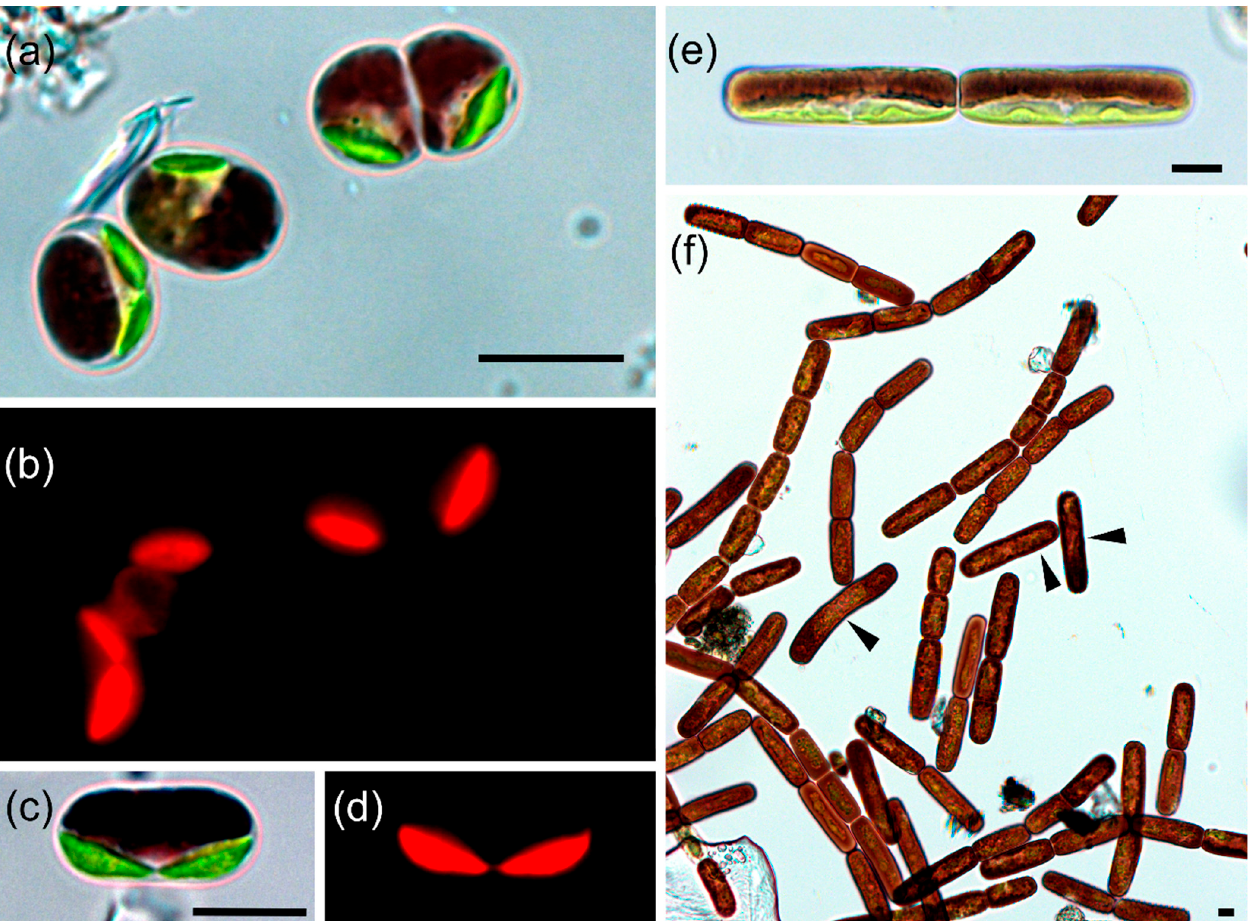
Figure 1. Light microphotographs of cells collected from melting glacier surfaces in the European Alps, ( a – d ) Ancylonema alaskana comb. et stat. nov. (WP167) and ( e , f ) Ancylonema nordenskioeldii (WP211). ( a ) transient stage of two cells after cleavage (upper right), showing one parietal chloroplast per cell in the side view (upper right and middle) or two chloroplasts before cell cleavage (lower left) (WP167), ( c ) elongated cell with two chloroplasts, ( a – d ) corresponding bright field and fluorescence images, the latter reveal the partly lobed chloroplast shape. ( e ) side view demonstrating two parietal chloroplasts per cell (or one with two pyrenoids), ( f ) group of dark pigmented filaments, most of them with 2, 4 or 8 cells, but also single individuals were present (arrowheads). Scale: 10 µ